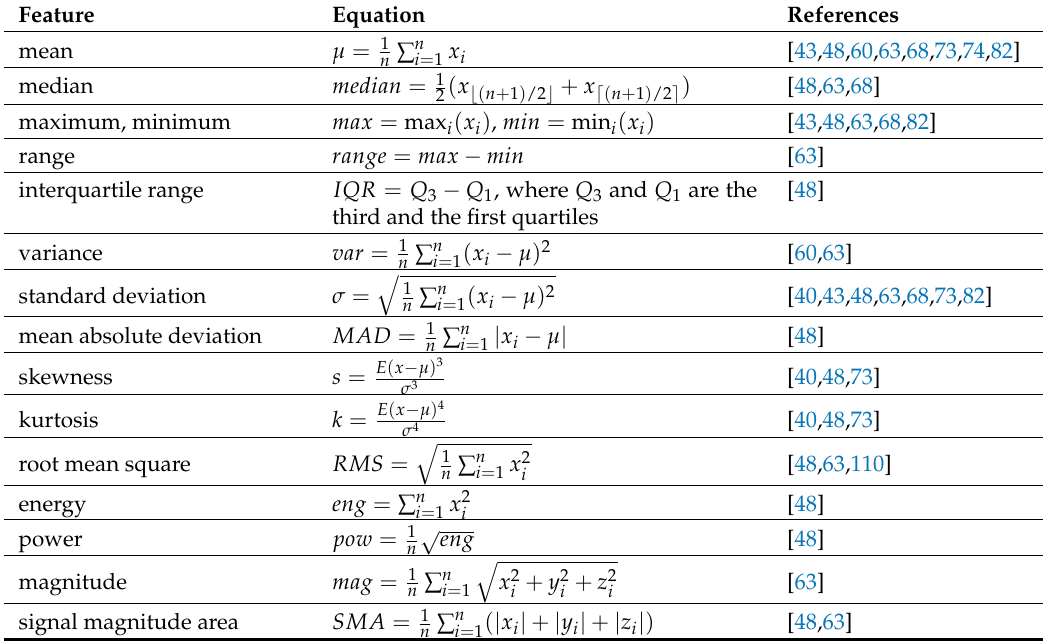
Table 1. Low-level features extracted on the basis of accelerometer time series